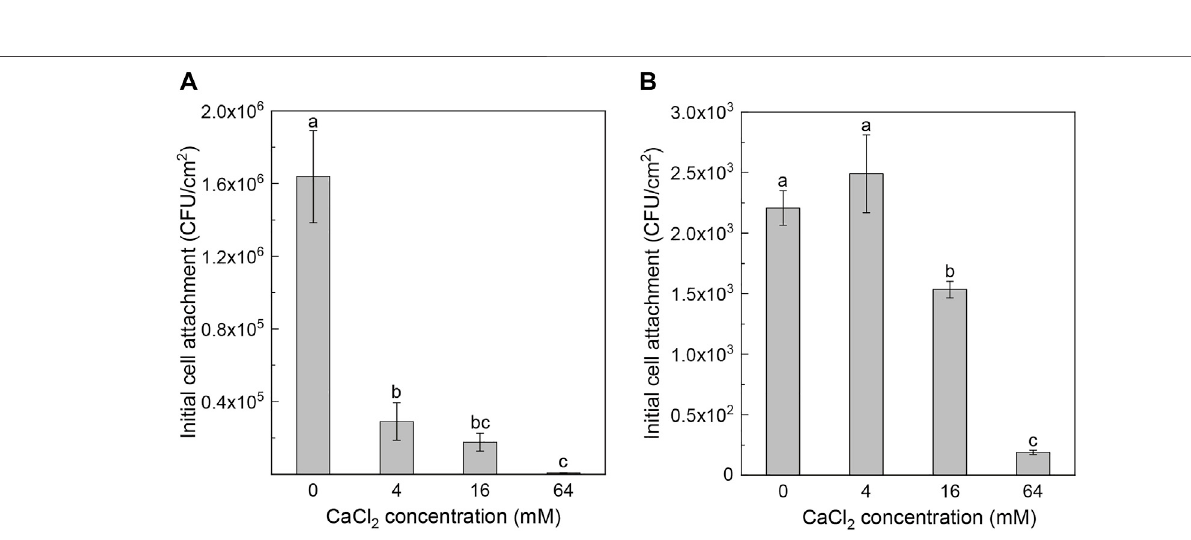
FIGURE 3 | Effects of adding CaCl 2 on the initial cell attachment of Pseudomonas sp. ZX01 (A) and Arthrobacter sp. ZX07 (B) on glass substrate under shaking conditions.Barsrepresented mean±standarddeviation.Differentlowercaseletterslabeledonthebarsrepresentedthesigni fi cantdifference( p < 0.05)accordingtothe one-way ANOVA and multiple